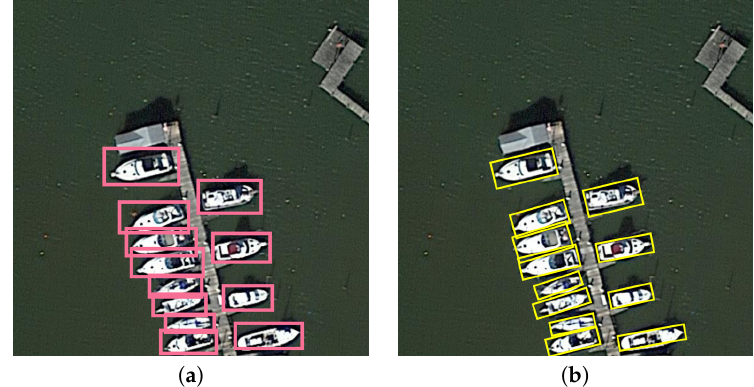
Figure 2. Two kinds of rectangular bounding boxes. ( a ) Standard rectangular bounding boxes: in addition to a boat, each rectangular bounding box contains pixels of water, docks, and other boats. ( b ) Inclined rectangular bounding boxes: the boxes contain fewer background